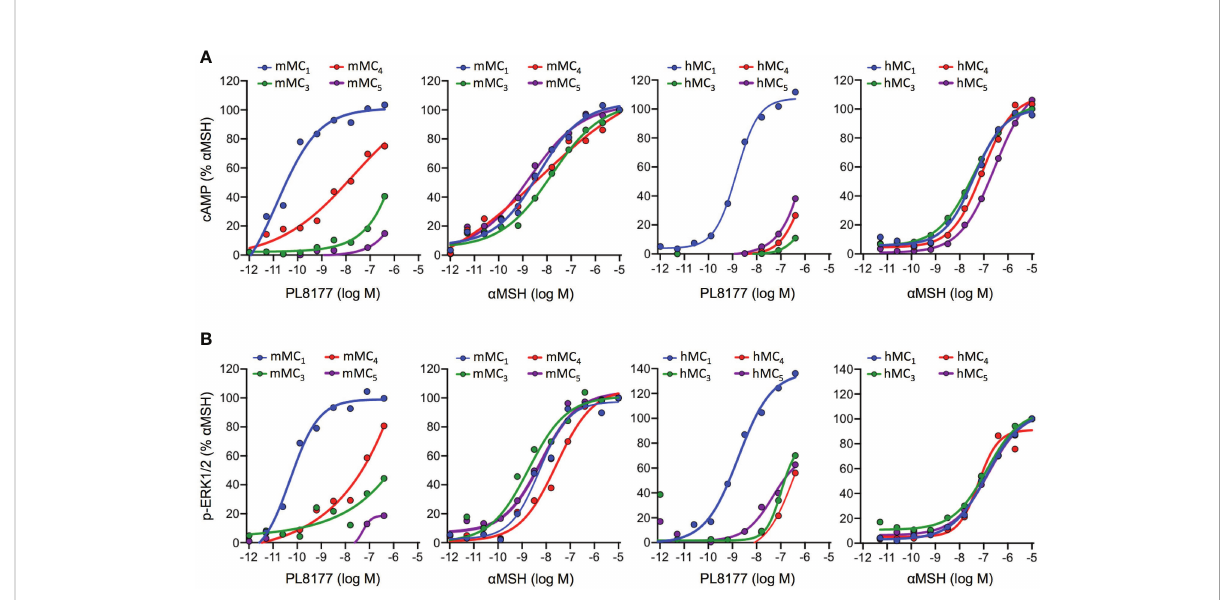
FIGURE 2 Melanocortin receptors signaling induced by PL8177 and a MSH. Concentration dependent accumulation of cAMP (A) and formation of ERK1/2 phosphorylation (p-ERK1/2) (B) upon agonist stimulation (15 min for cAMP; 5min for p-ERK1/2) of HEK293A cells transiently transfected with mouse or human Melanocortin (MC) receptors. Data are expressed as percentage of maximal a MSH response and represent mean values of n=3 independent experiments, each one performed in